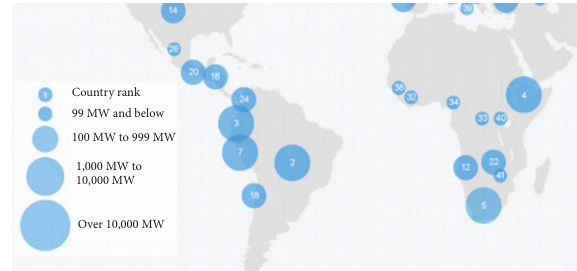
Figure 6: Hydropower capacity installed in 2016. Source: Hydropower Status Report